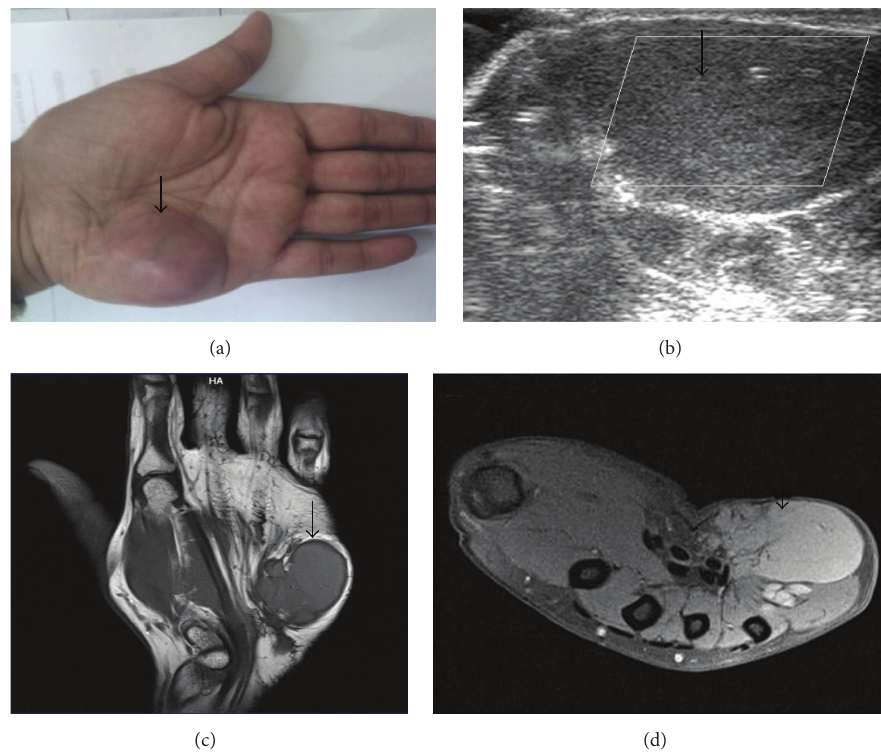
Figure 8: Synovial sarcoma. A 34-year-old female patient presented with noncompressible swelling involving hypothenar eminence of left hand ((a), arrow). Ultrasonography shows a hypoechoic lesion with absent color flow (b). MRI shows a large, lobulated T1W hypointense ((c), arrow) and T1WFS hyperintense ((d), arrow) lesion.